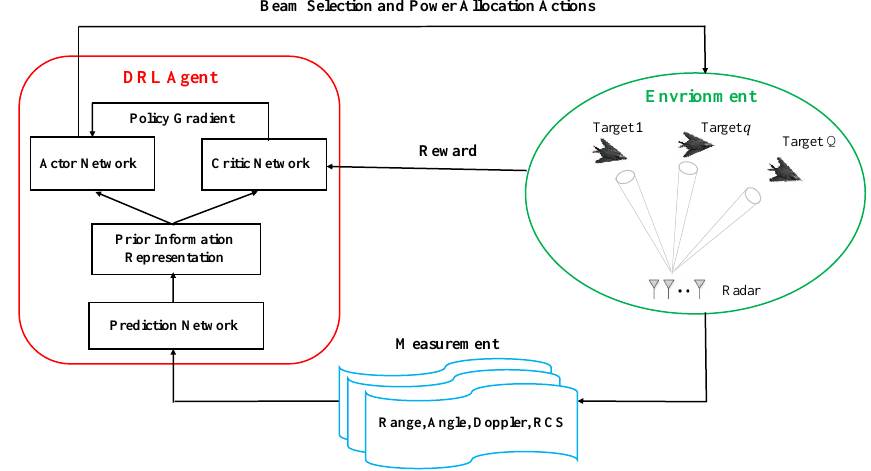
Figure 1. The system architecture of